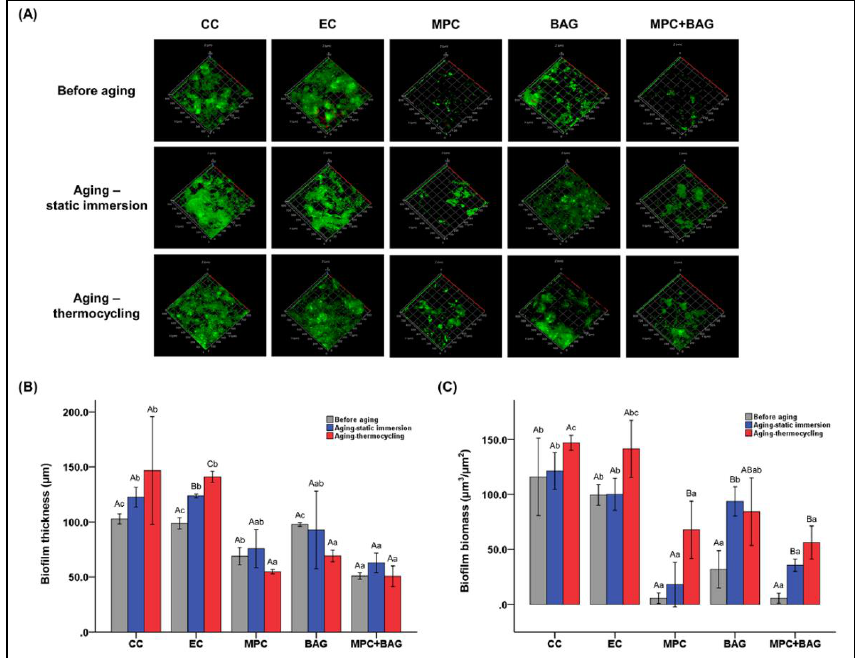
Figure 7. Durable action of MPC added at 3 wt.%, with and without the addition of the bioactive glass (BAG) fillers. ( A ) Confocal laser scanning microscopic images showing extent of the biofilm; ( B ) measurement of the biofilm thickness; and ( C ) biomass at a µm scale. The uppercase and lowercase letters indicate the statistically significant differences within the groups and between groups, respectively at p = 0.001 [57] .